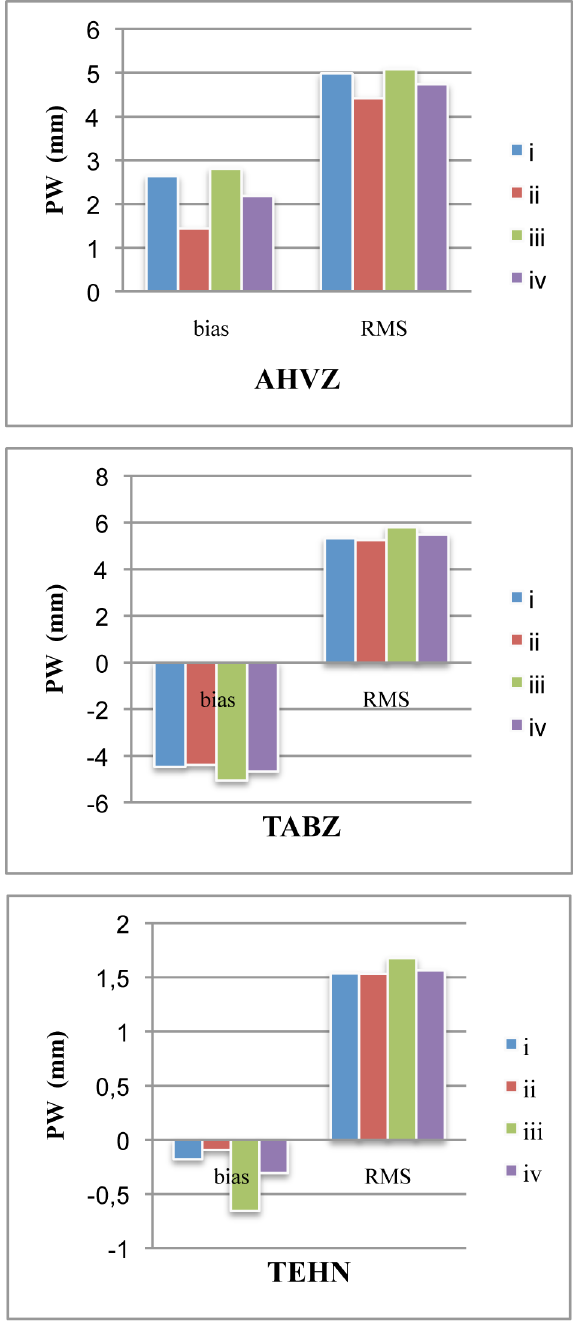
Figure 2 (top to bottom). The RMS and bias of the proposed as well as the existing models in the rainy months: i) linear model proposed in Bevis et al. [1992], ii) linear model proposed in this research, iii) quadratic model proposed in Emardson and Derks [2000] and iv) quadratic model proposed in this research.